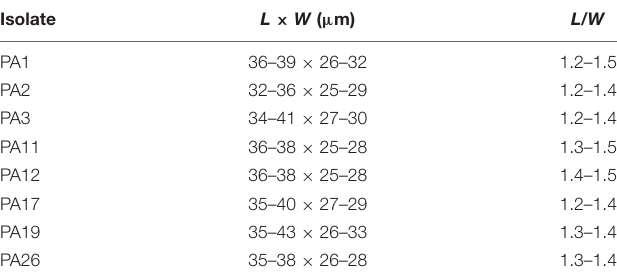
TABLE 2 | Morphometric characteristics ( n = 20) of cultured cells of the Prorocentrum lima species complex (PLSC) from the Gulf of Mexico